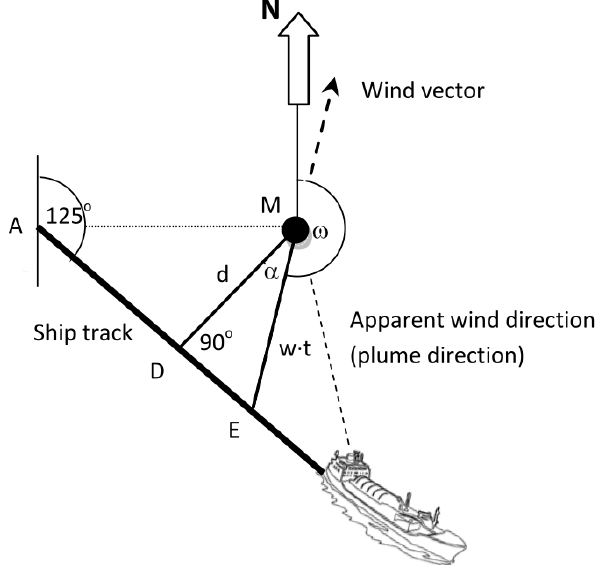
Fig. 4. Geometric scheme of the plume measurement. A thick black Figure 4. Geometric scheme of the plume measurement. Thick black line represents 981 line represents the ship’s track. Point M marks the measurement the ship‟s track. Point M marks the measurement location; point D is the position of 982 location; point D is the position of the ship when d distance was the ship when d distance was measured; the measured plume parcel was emitted at 983 measured; the measured plume parcel was emitted at point E; w , ω and t are the wind speed, wind direction and plume’s age, respec- point E; w , and t are the wind speed, wind direction and plume‟s age respectively. 984 tively. The direction of the channel was 125 ◦ at the measurement The direction of the channel was 125 o at the measurement point. 985 986